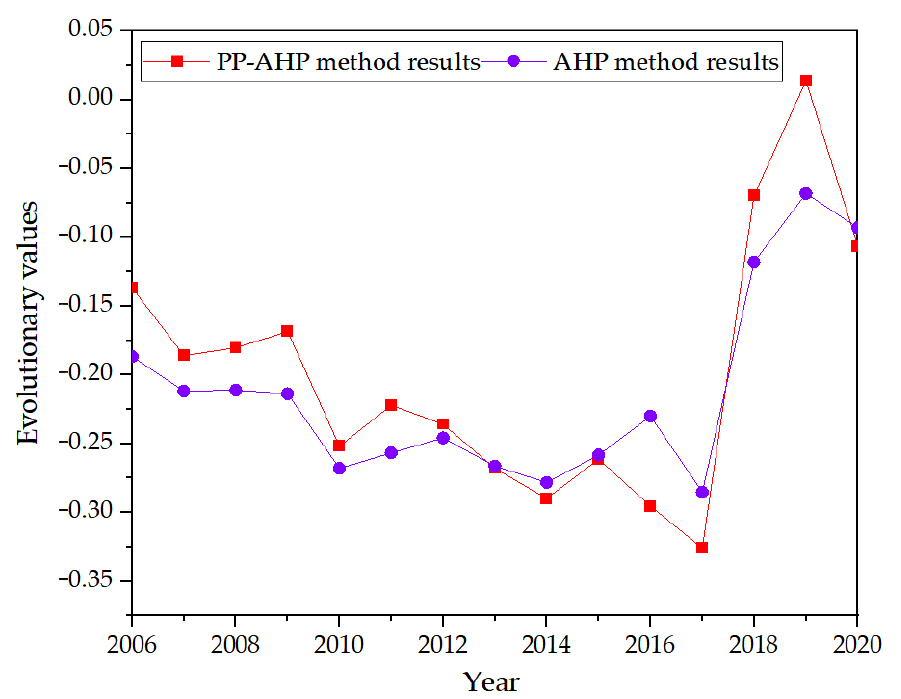
Figure 5. Dynamic evolution of the value of the bearing capacity level.